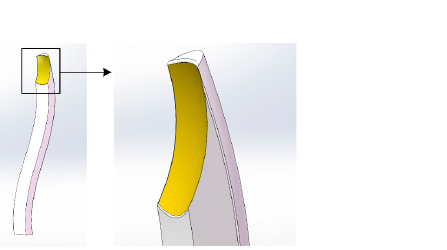
Figure 6. The design of finger end surface. Note: the yellow area is the surface.